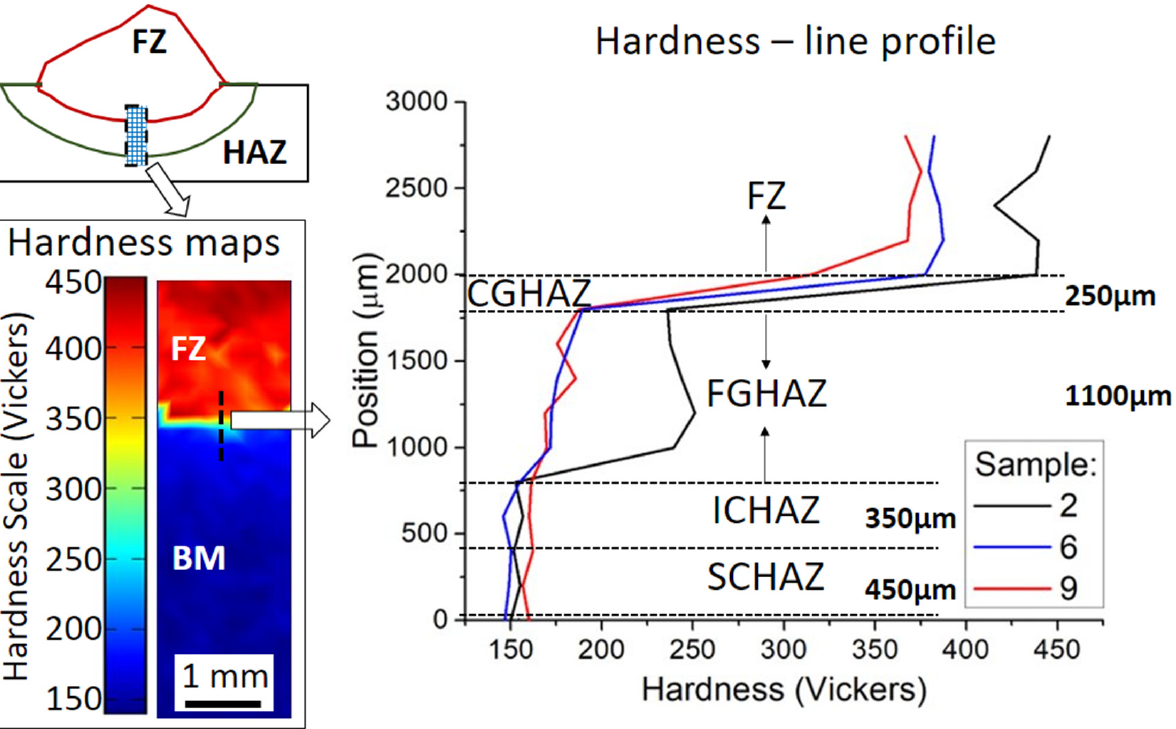
Figure 15. Hardness distribution in a 3 mm range of transition between the fusion zone (FZ) and base metal (BM).